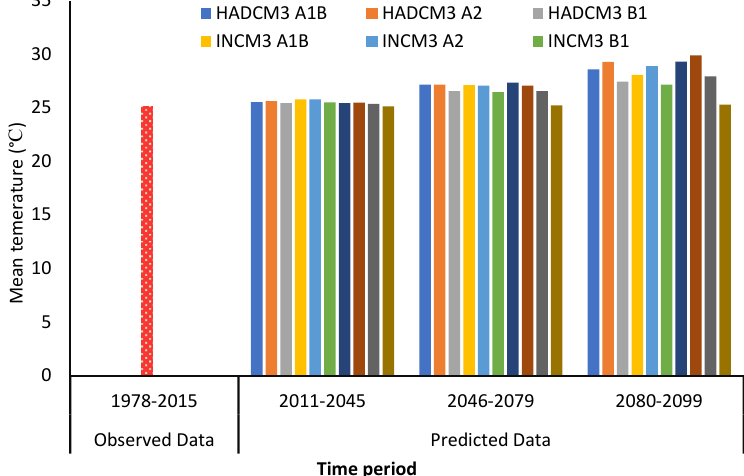
Figure 9. Annual mean temperature predicted by the various models.